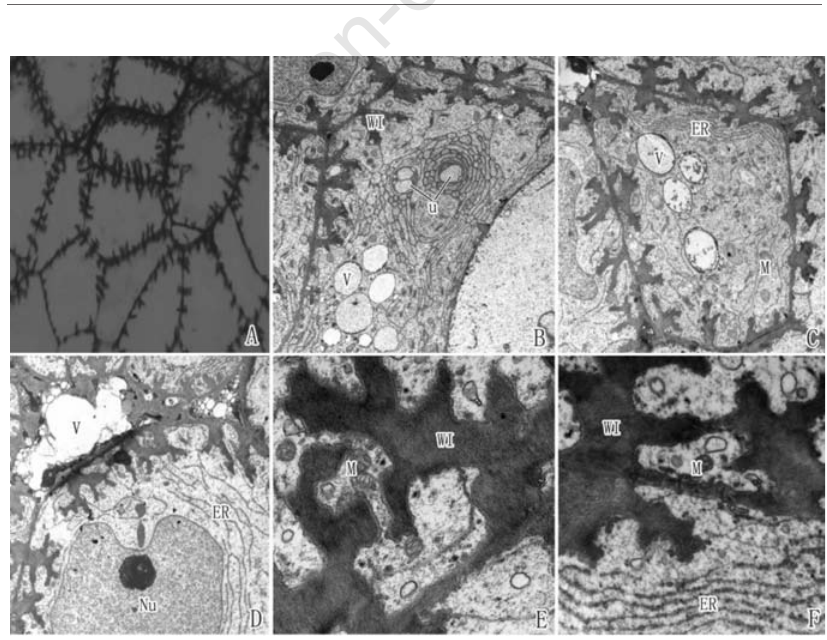
Figure 2. Structure of sorghum endosperm transfer cells (cells cut transversely). (A) sorghum endosperm transfer cells under the light microscope (magnification: 1000X); (B,C,D) sorghum endosperm transfer cells under the transmission elec- tron microscope (3900X); (E,F) wall ingrowths of sorghum endosperm transfer cells under the transmission electron microscope (18500X). WI, wall ingrowths; M, mitochondrion; ER, endoplasmic reticu lum; V, vacuole; Nu, nucleus; u, uncertain